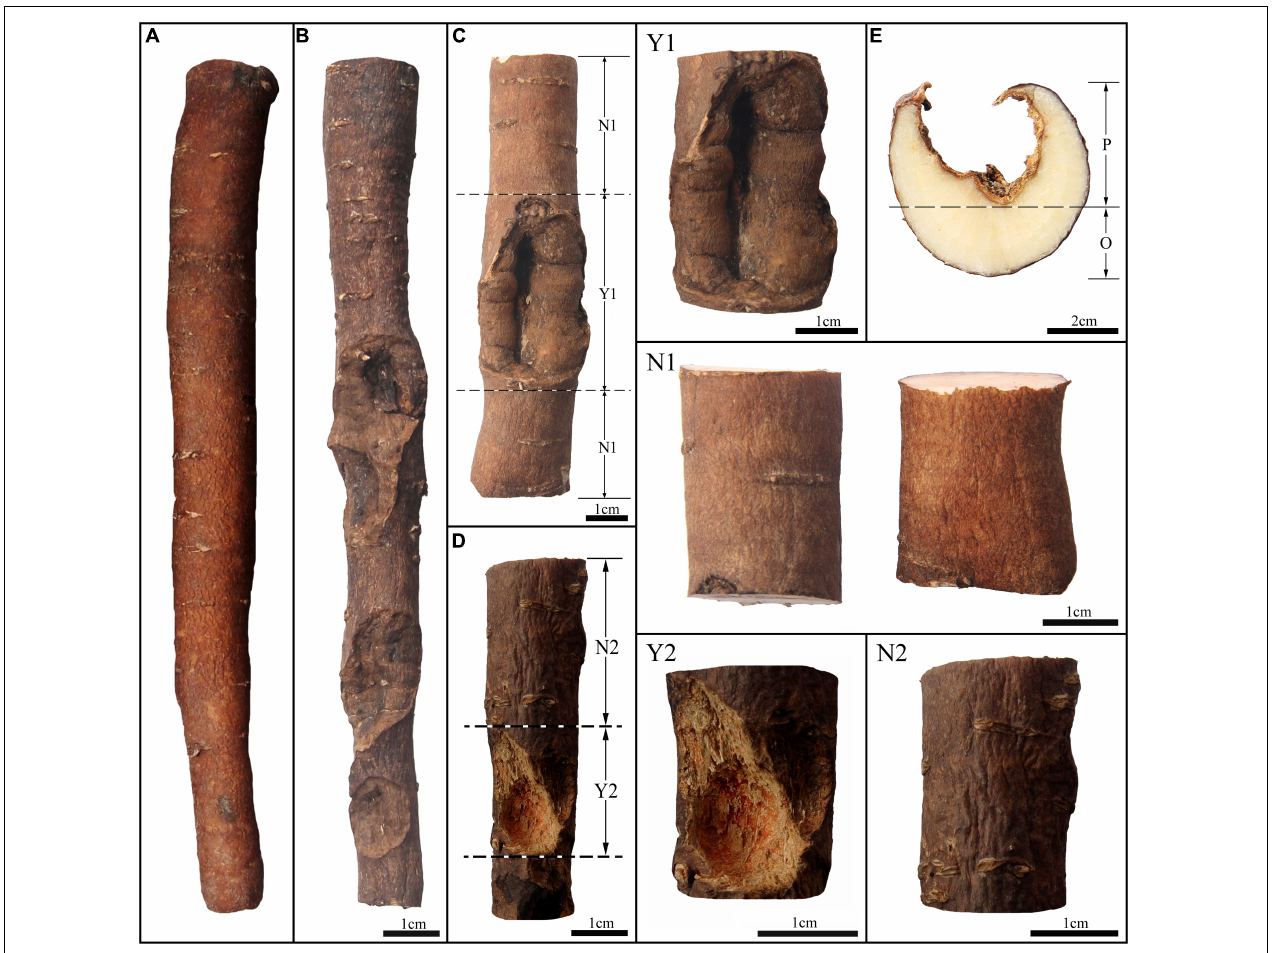
FIGURE 2 | Morphological characters of P. lactiflora roots with and without “pockmarks.” P. lactiflora root without “pockmarks” (A) and with “pockmarks” (B) ; root with old formed “pockmarks” (C) ; root with newly formed “pockmarks” (D) ; divided parts with (Y1) and without (N1) old formed “pockmarks” in the same root; divided parts with (Y2) and without (N2) newly formed “pockmarks” in the same root; transverse section of P. lactiflora root with “pockmarks” (E) , P, the part with “pockmarks” and O, the part without “pockmarks.”